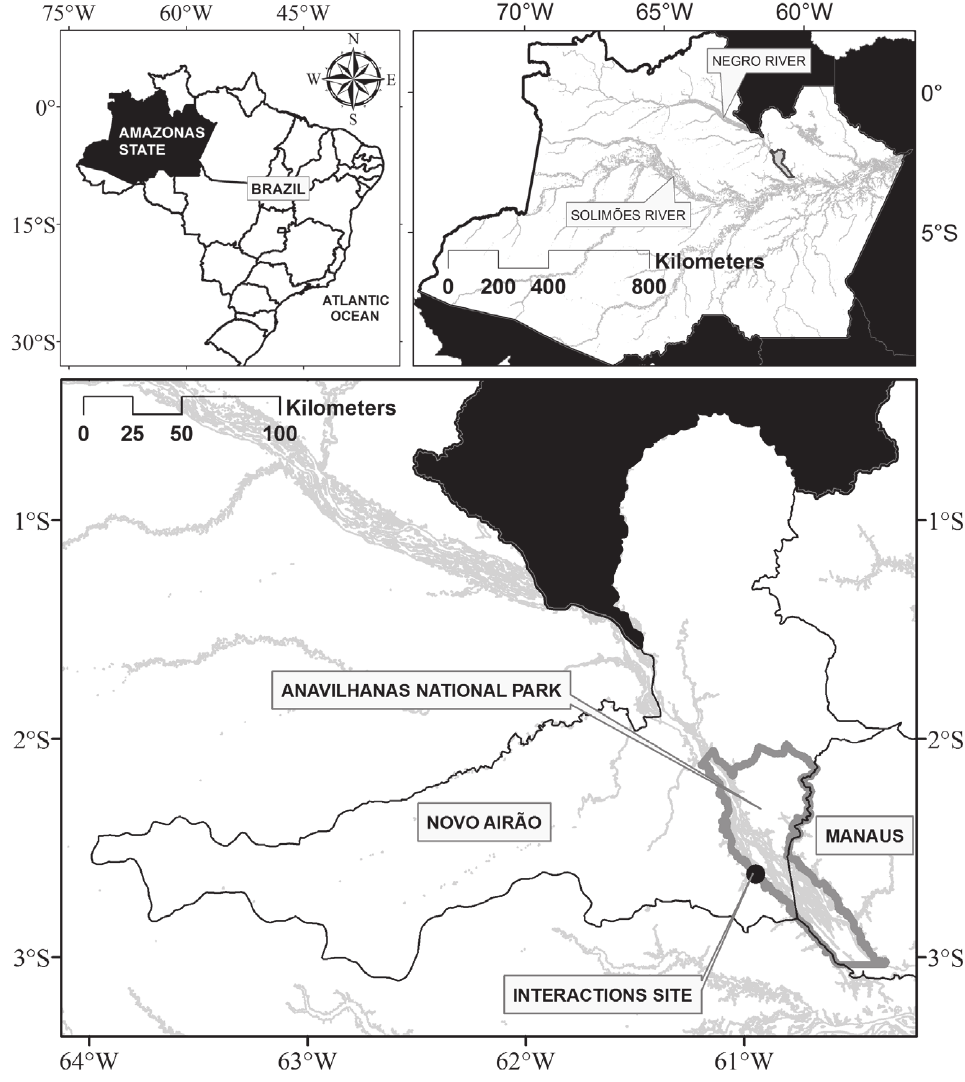
Figure 1 - Upper left: Amazonas State in Brazil; upper right: Anavilhanas National Park in Amazonas State; down: Anavilhanas National Park in the municipalities of Manaus (Capital of the State) and Novo Airão and the interaction site, located in Novo Airão